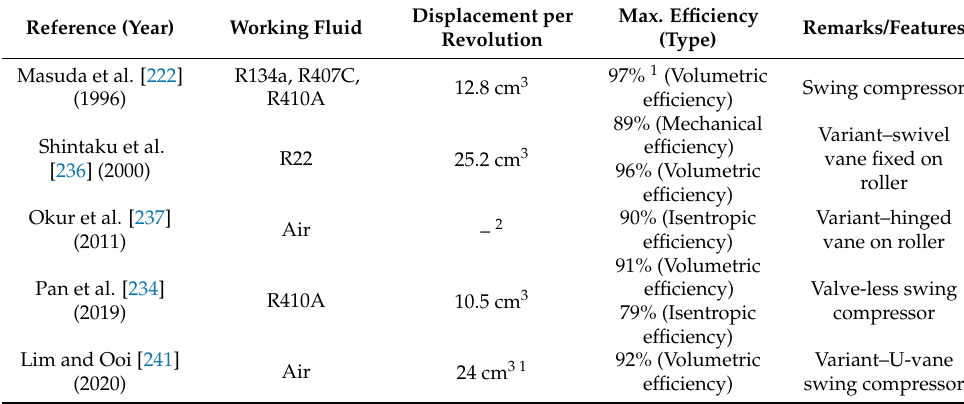
Table 7. Swing mechanism compressor performance.